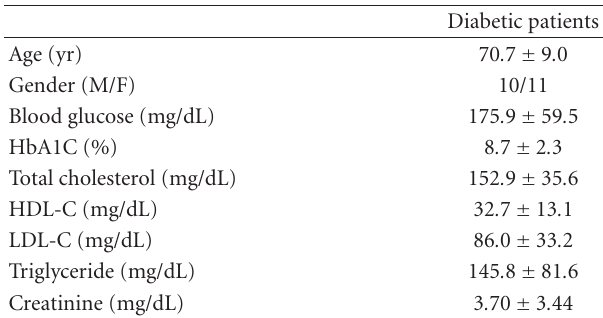
Table 1: Characteristics of the